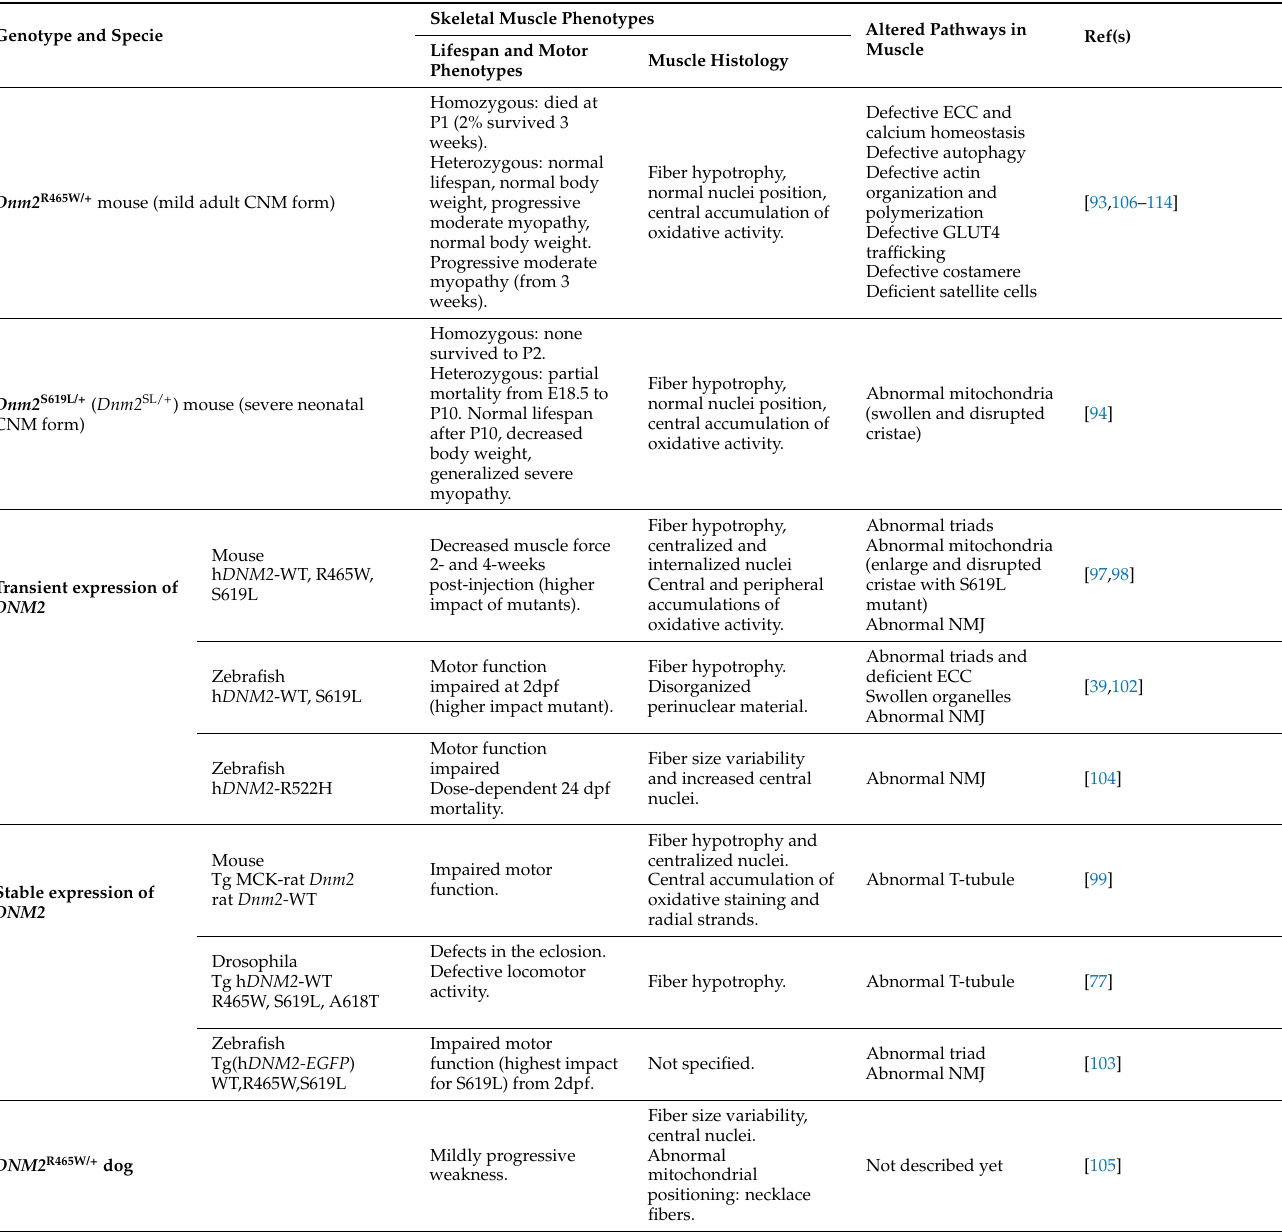
Table 3. Main fish and mammalian models for DNM2-related